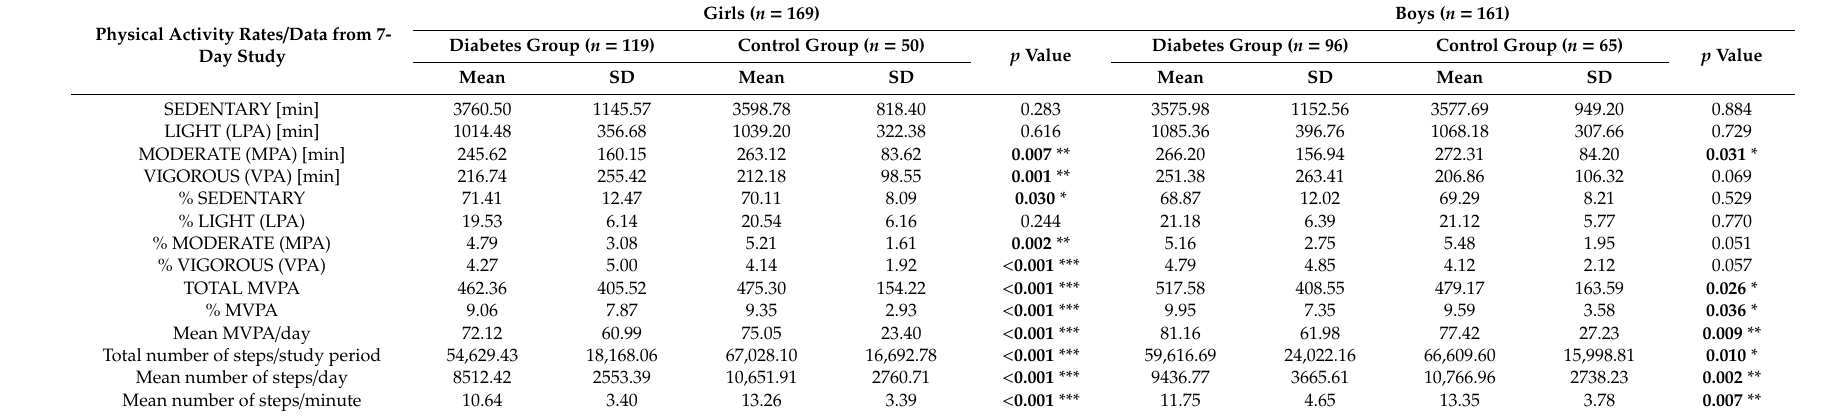
Table 4. Comparison of physical activity rates in the diabetes and the control groups depending on sex.